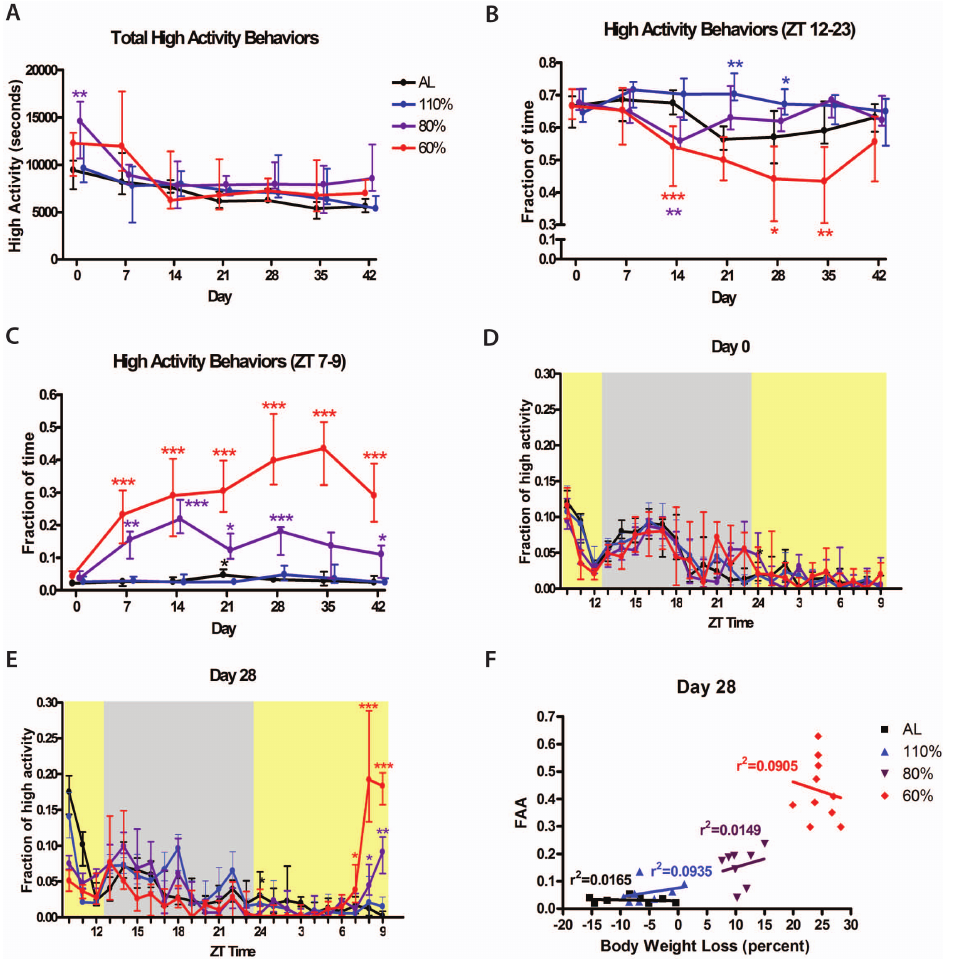
Figure 3. High activity behaviors of mice in on different food restriction amounts. (A) The total amount of high activity behaviors (in seconds) during weekly 24 hour video recordings for mice on AL, 110%, 80%, and 60% CR. (B) Normalized nocturnal high activity behaviors during weekly 24 hour video recordings for mice on AL, 110%, 80%, and 60% CR. (C) Fraction of time spent on high activity behaviors in the 3 hours preceding meal presentation (ZT 7–9). (D) Normalized fraction of time per hour spent on high activity behavior during the 24-recording of day 0 (D) and (E) day 28 of dose-response experiment. Values represent medians + / 2 IQ range, with high activity values normalized to total daily activity (significance tested with Mann-Whitney test with Dunn’s post test for all treatment groups vs. AL controls for each respective day). *denotes p , 0.05, **denotes p , 0.01, and ***denotes p , 0.001. n=8 for all groups except for 60% CR where n=10. (F) Correlation and linear regression of normalized food anticipatory activity in the 3 hours preceding scheduled feeding with % body weight